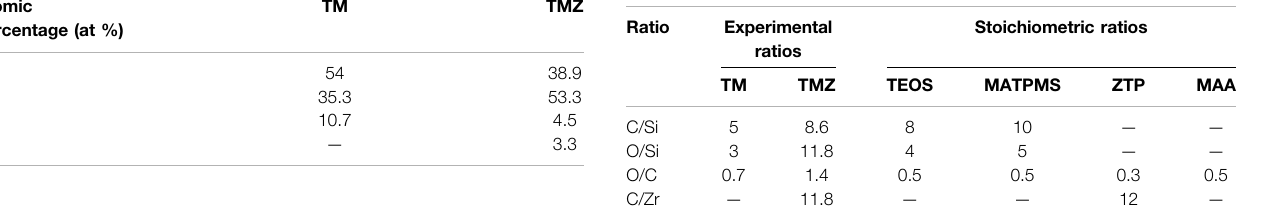
TABLE 3 | Experimental atomic ratios of TM and TMZ coatings determined from high energy resolution XPS spectra before immersion in corrosive medium andstoichiometricratios determined fromchemicalformulaeofsol-gelprecursors TEOS, MAPTMS, ZTP and